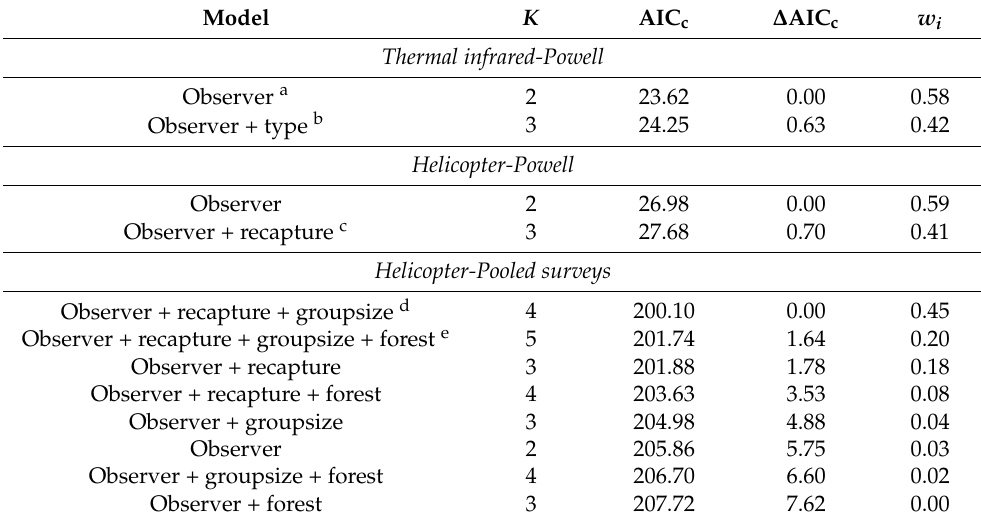
Table 2. Model-selection results of bison detection probability from three different datasets: a thermal infrared survey on Powell Plateau, a helicopter survey on Powell Plateau, and a pooled dataset from three helicopter surveys of the North Rim of Grand Canyon National Park, USA. Columns represent the number of parameters ( K ), Akaike’s Information Criterion adjusted for small sample sizes (AIC c ), difference between a given model and the top-ranked model ( ∆ AIC c ), and the model weight ( w i